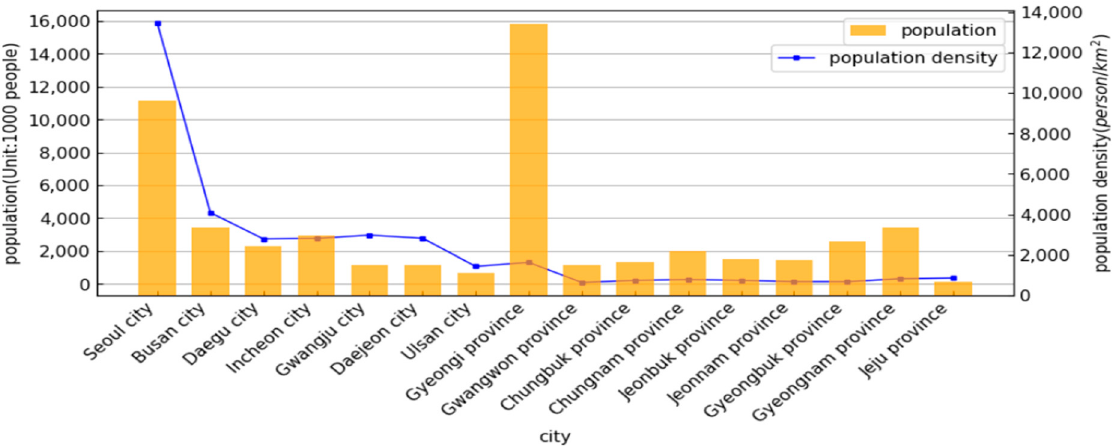
Figure 3. Total Population and Population Density by City/Province of Korea in 2020.